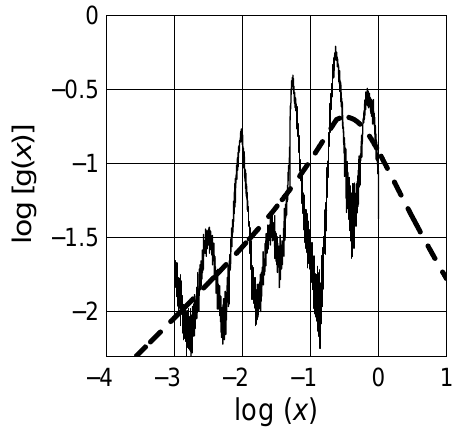
Figure 16 . Comparison of the distributions sfg obtained by the Havriliak-Negami approach (– – –) and the novel numerical approach (——–). Observe that the Havriliak-Negami distribution also considers spectral parameter x values larger than 1, log( x ) > 0 . Logarithmic scale is base 10.